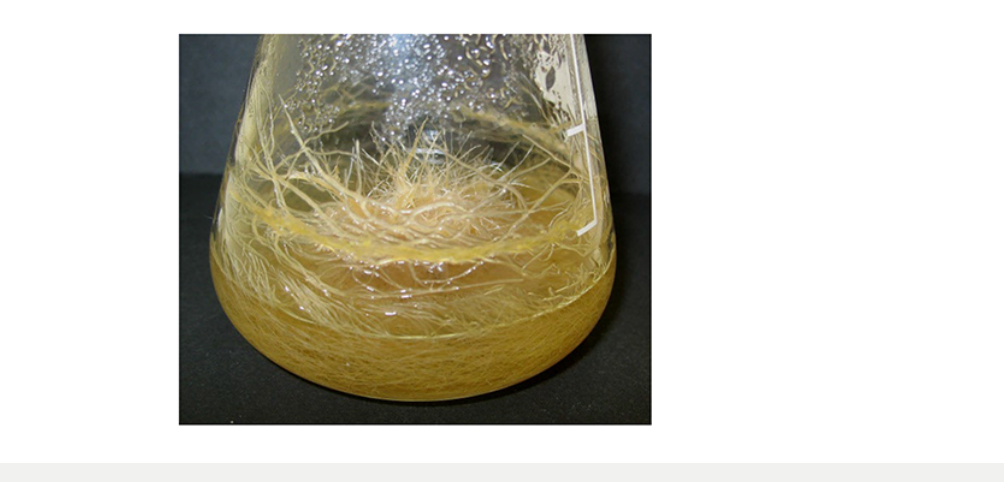
Figure 18 Hairy roots of Scutellaria lateriflora